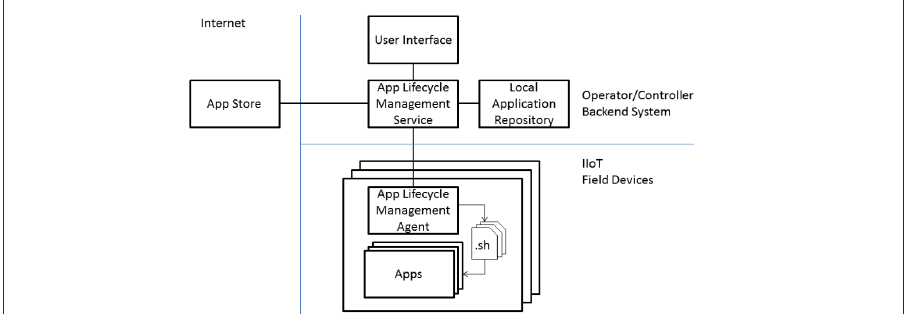
Figure 2 Generic Application Lifecycle Management Implementation